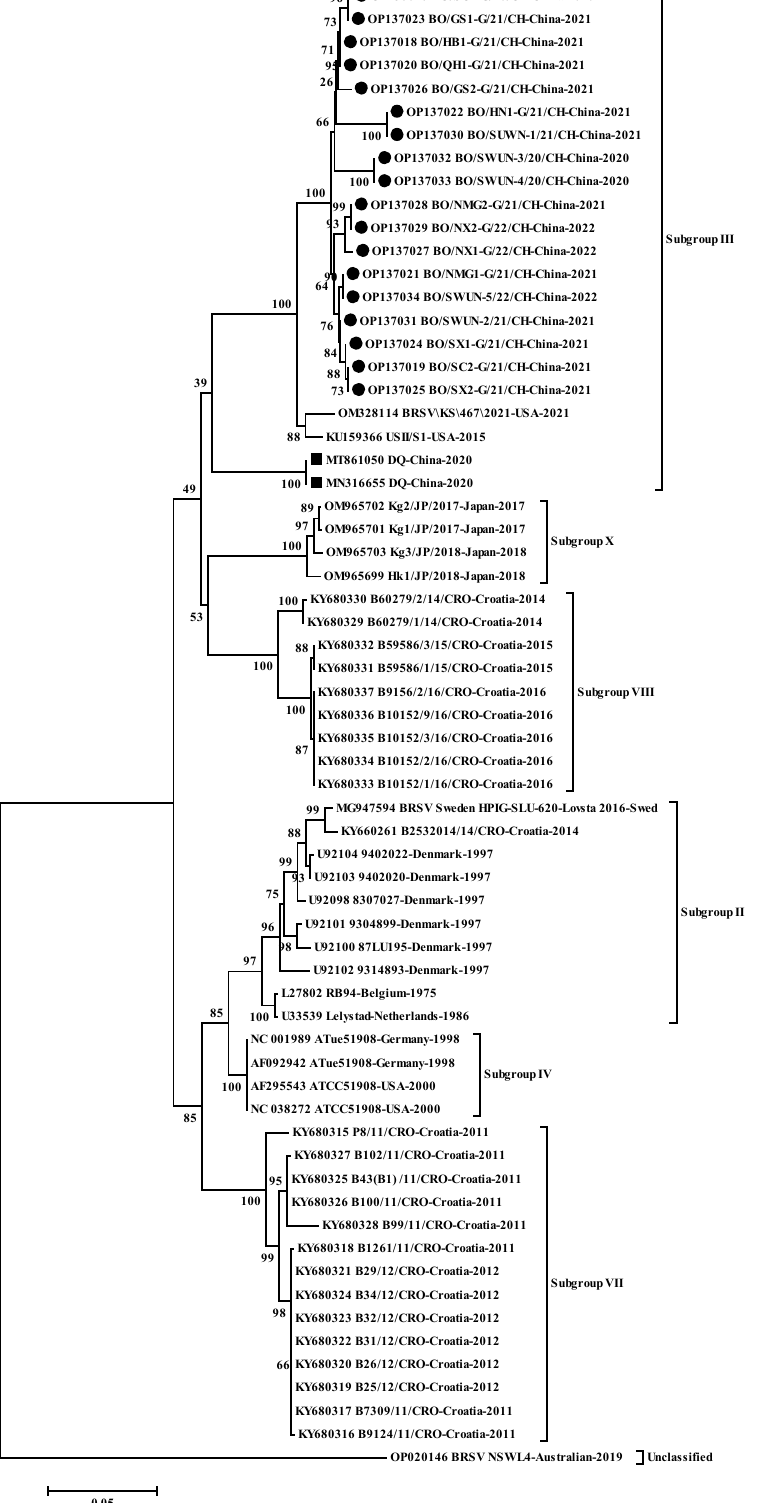
Figure 2. Phylogenetic tree based on the complete nucleotide sequences of G gene. Sequences were compared and clustered by MEGA 7.0 software. The phylogenetic tree was constructed using the neighbor ‐ joining method (1000 replicates). ● represents 18 G gene sequences of BRSV strains from this study, represents the G gene sequences of other strains in China.